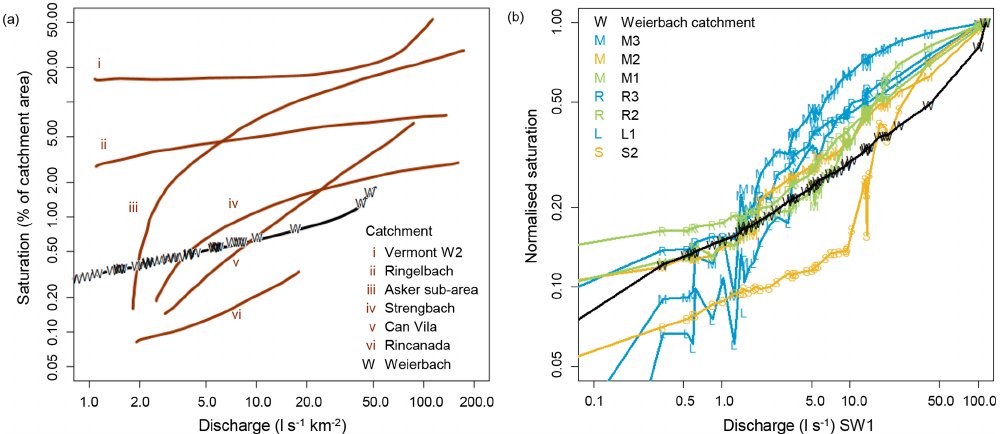
Figure 8. Simulated relationship between discharge and surface saturation of the entire Weierbach catchment (marked with W) in comparison to (a) the relationships observed in other catchments (figure modified from Latron and Gallart, 2007) and (b) the relationships simulated for the seven investigated riparian areas within the catchment (cf. Fig. 6). The data for the relationships from the other catchments are from (i) Dunne et al. (1975), (ii) Ambroise (1986), (iii) Myrabø (Myrabø, 1986), (iv) Latron (Latron, 1990), (v) Latron and Gallart (2007), and (vi) Martínez Fernández et al.